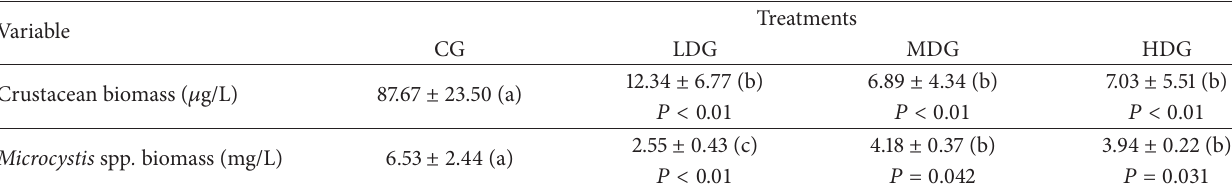
Table 4: Crustacean and Microcystis biomass for each treatment. Statistics are performed as mean ± STDEV; means with different minuscules stand for significant